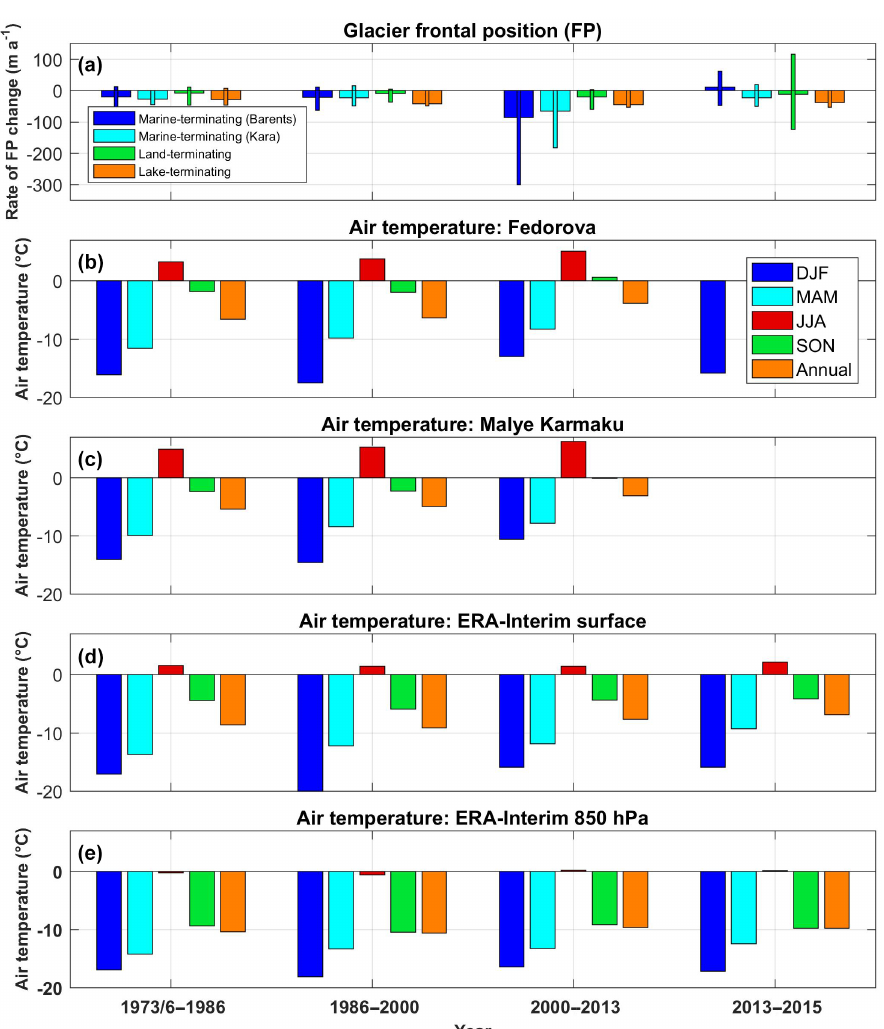
Figure 4. Mean retreat rates for Novaya Zemlya outlet glaciers, and mean air temperatures at E. K. Fedorova (WMO ID: 20946) and Ma- lye Karmaku (WMO ID: 20744) (Fig. 1). Data are split into four time periods, based on manually identified breaks in the glacier retreat data: 1973/76–1986, 1986–2000, 2000–2013, and 2013–2015. (a) Retreat rates were calculated separately for different terminus types, and marine-terminating glaciers were further sub-divided into those terminating into the Barents Sea versus the Kara Sea. Wide bars represent mean values, and thin bars represent the total range (i.e. minimum and maximum values) within each category. (b–e) Mean seasonal air temperatures (December–February, March–May, June–August, and September–November) and mean annual air temperatures for E. K. Fe- dorova (b) , Malye Karmaku (c) , ERA-Interim surface (d) , and ERA-Interim 850hPa pressure level (e) . Note that only mean values for E. K. Fedorova in January–March are calculated for 2013–2015, due to data